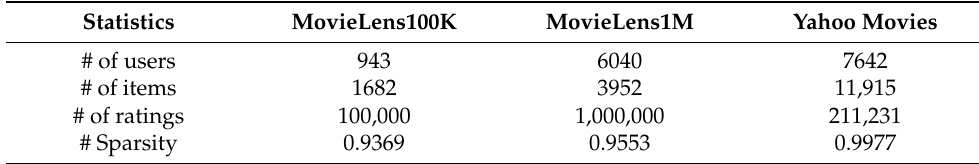
Table 1. Statistics of the